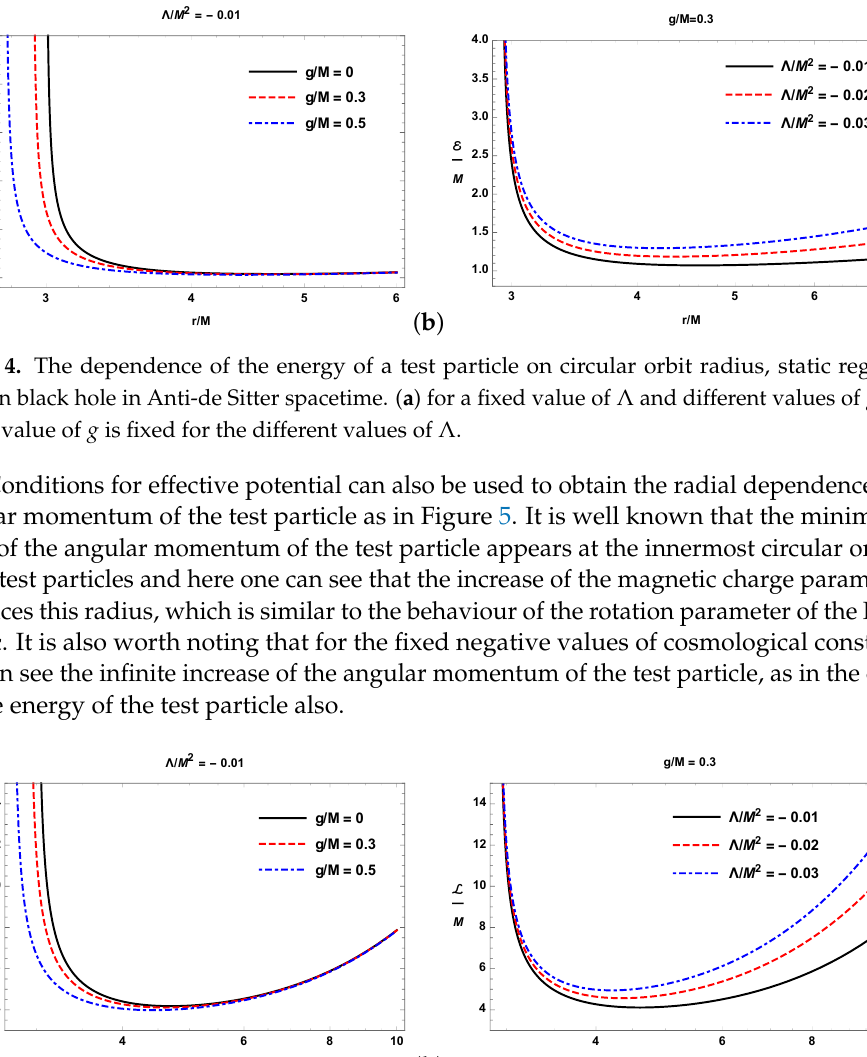
Figure 4. One can see that the increase of the magnetic charge parameter decreases the energy near the central object, while the increase of the absolute value of negative cosmo- logical constant makes the energy to increase infinitely since it has an infinite contribution Λ r 2 to the spacetime metric as − that increases infinitely for r → ∞ . 3